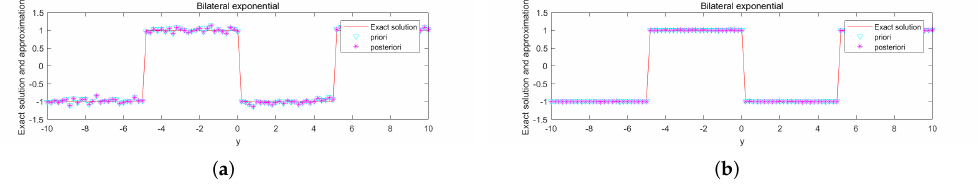
Figure 2. ( a ) δ = 1 × 10 − 1 . ( b ) δ = 1 × 10 − 2 . The exact solution and the regularized solution of a ( x ) when α = 1.8.